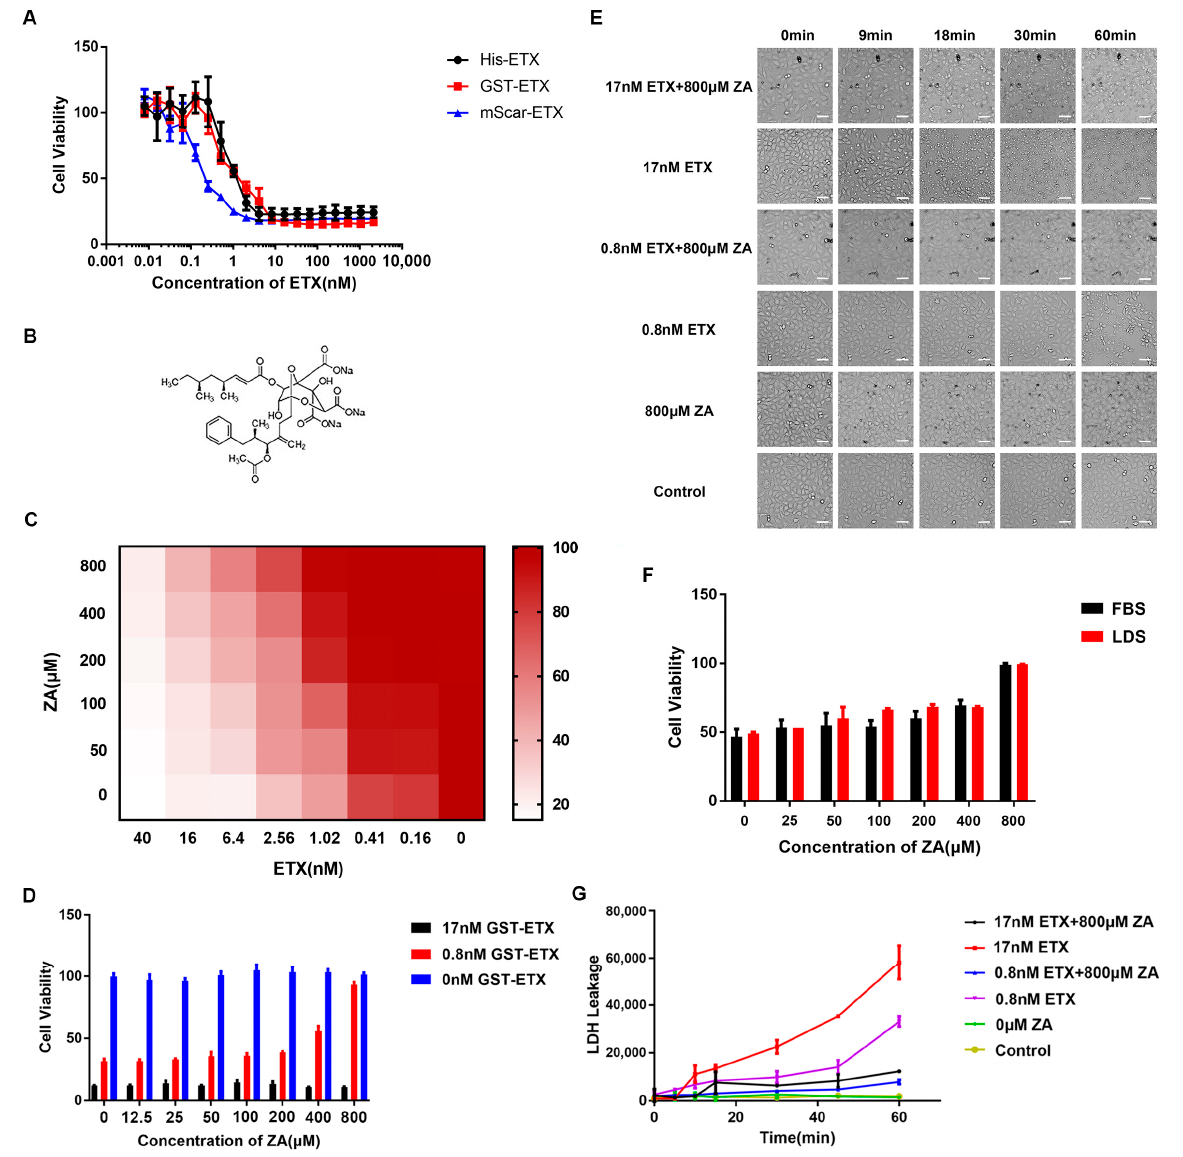
Figure 1. Cytotoxicity of Epslion toxin (ETX) toward Madin–Darby canine kidney (MDCK) cells was inhibited by Zaragozic acid A trisodium salt (ZA). ( A ) Toxicities of ETX with different tags are similar. ( B ) Chemical structure of ZA. ( C , D ) Cell viability (from MTS assays) in MDCK cells exposed to increasing concentrations of ZA for 30 min and then incubated with different concentrations of ETX with GST tag (GST-ETX) for 1 h. ( E ) MDCK cells were preincubated with ZA for 30 min and incubated with ETX and continuously observed for 1 h. Scale bar: 50 µ m. ( F ) The MDCK cells were cultured for 24 h with DMEM supplemented with 10% fetal bovine serum (FBS) or 10% lipid-depleted fetal bovine serum (LDS) and then treated with ZA prior to exposure to 0.8 nM ETX. ( G ) MDCK cells treated with 800 µ M ZA for 30 min were exposed to ETX for 0, 5, 10, 15, 30, 45, and 60 min. Then, the Lactic Dehydrogenase (LDH) released from cells was measured using the LDH-Glo TM Cytotoxicity Assay Kit.